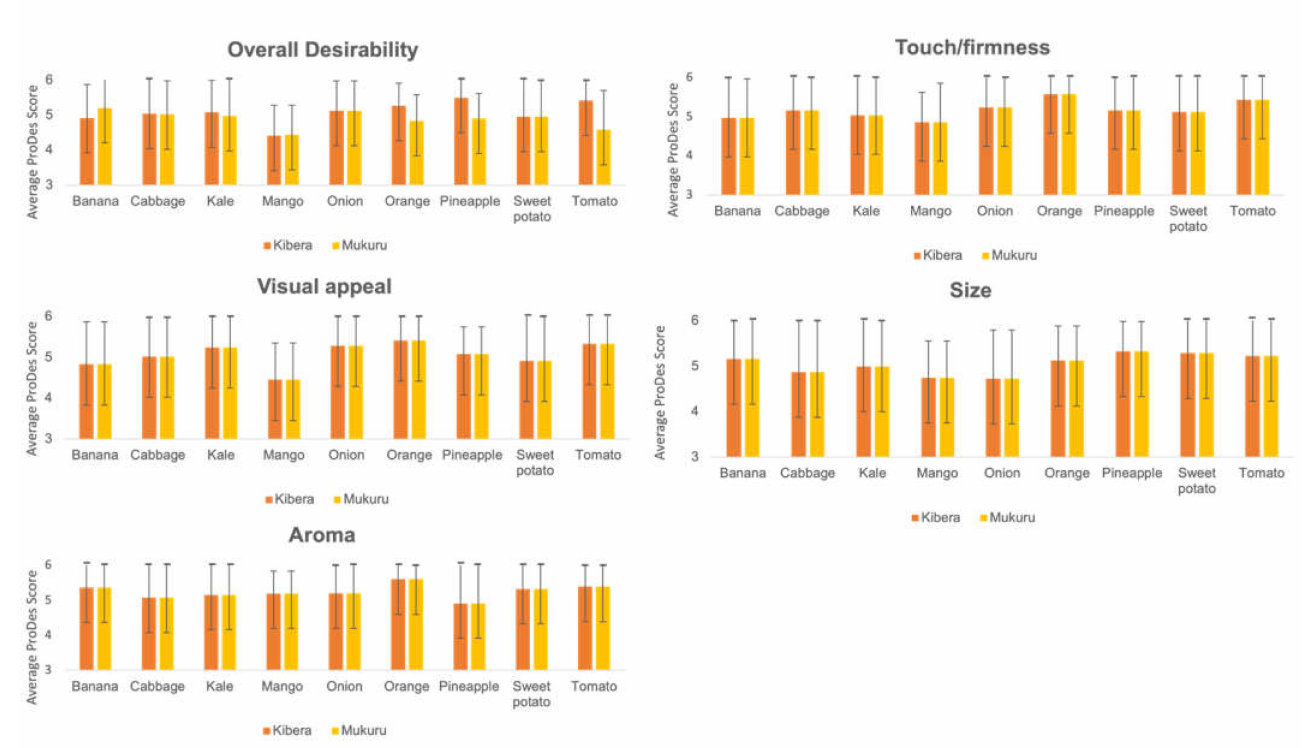
Figure 3. An overview of the ProDesirability scores for key fruits and vegetables in Kibera and